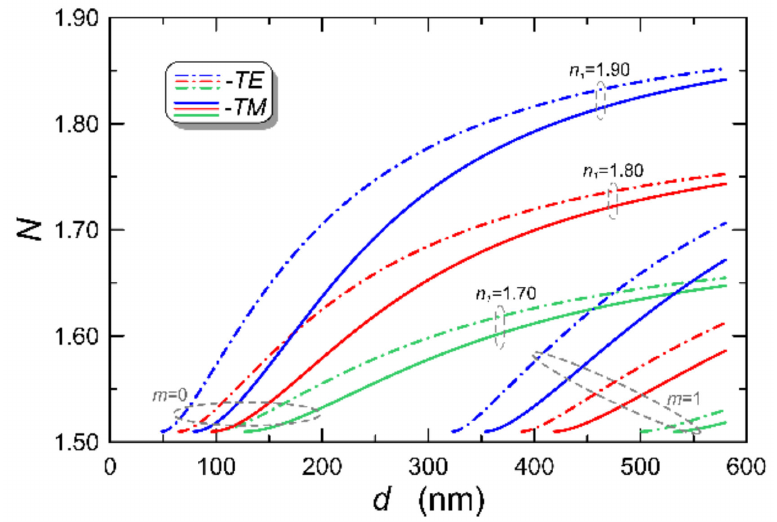
Figure 5. Modal characteristics of slab waveguides on glass substrates for selected values of the refractive index of the waveguide film. The remaining parameters have the following values: n b = 1.510, n c = 1.333, λ = 632.8 nm.